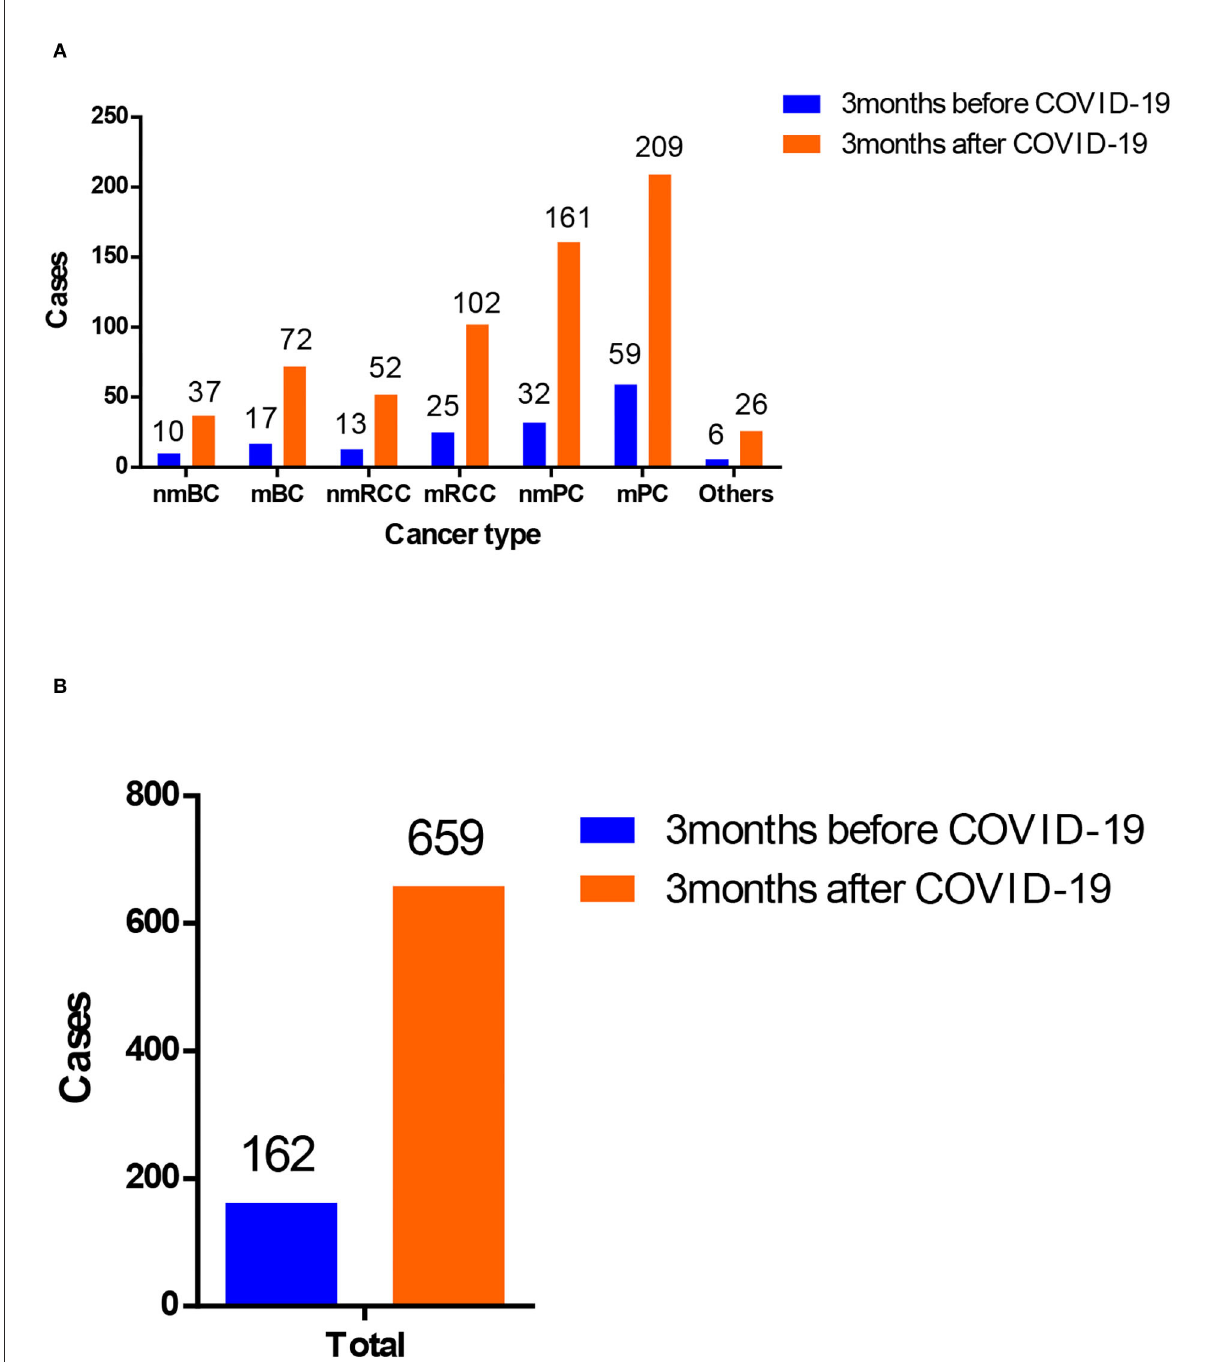
FIGURE3 Comparison of patients with genitourinary cancer receiving medical consultation from online MDT platform in China before and after the outbreak of coronavirus disease 2019 (COVID-19). (A) Patients with different cancer types of genitourinary cancer and (B) overview of patients with genitourinary